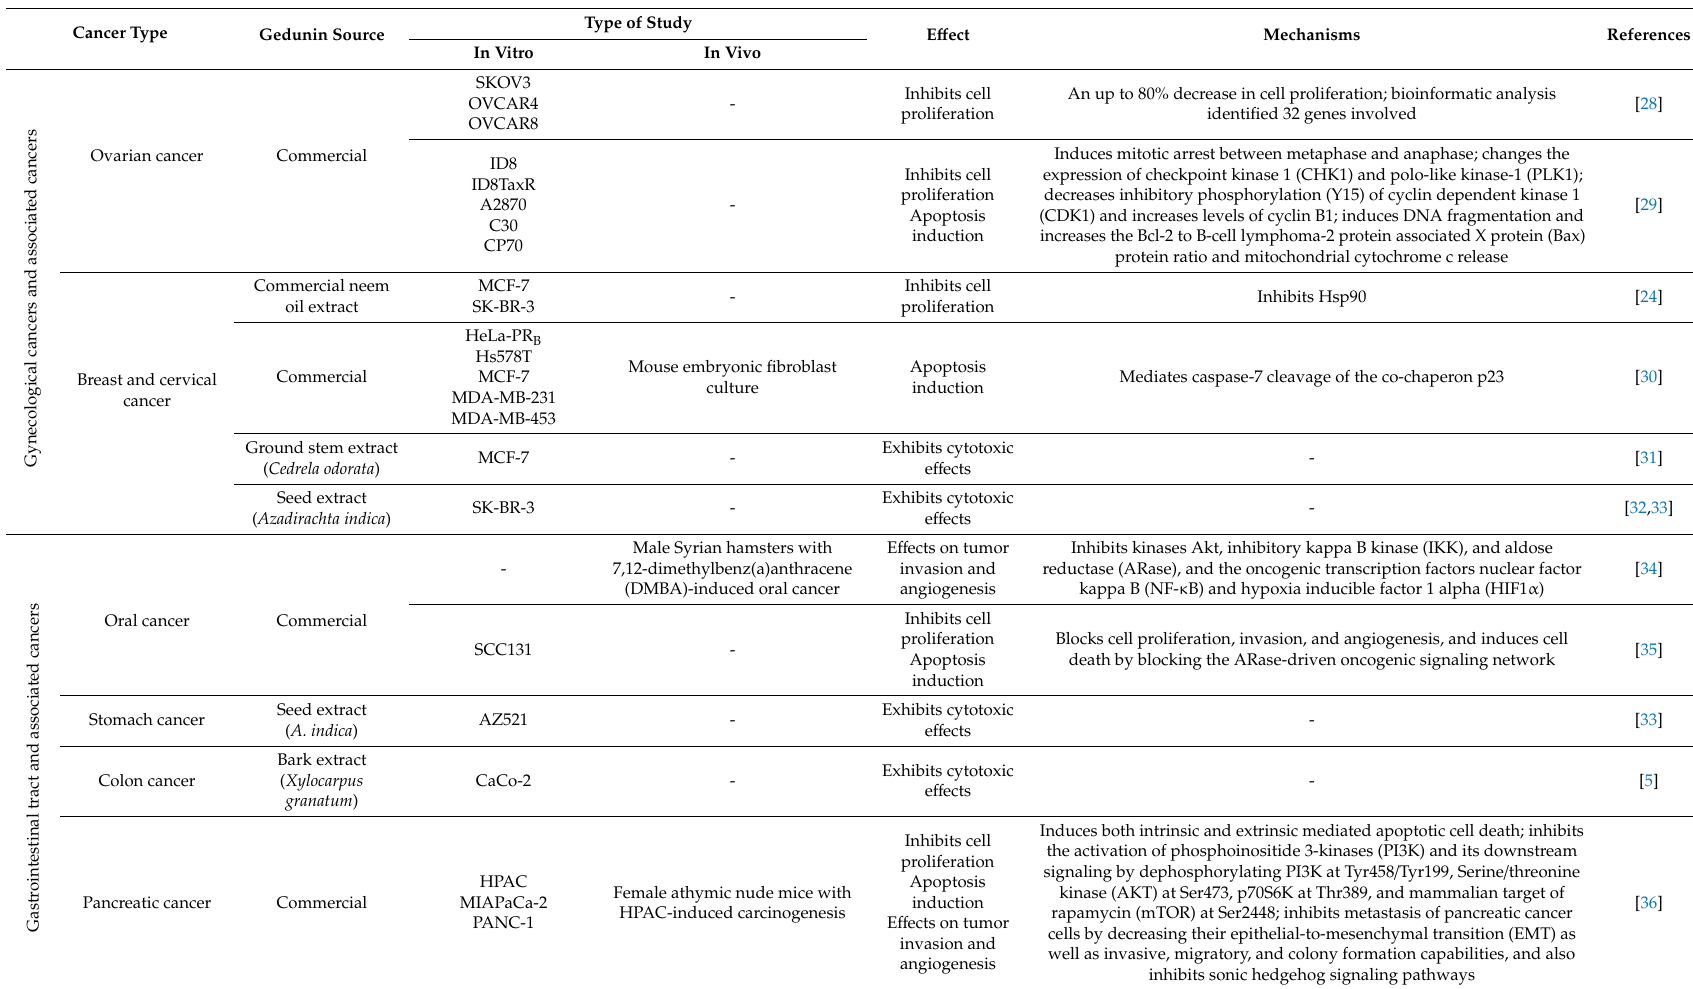
Table 1. Comparative anticarcinogenic properties of gedunin in di ff erent types of